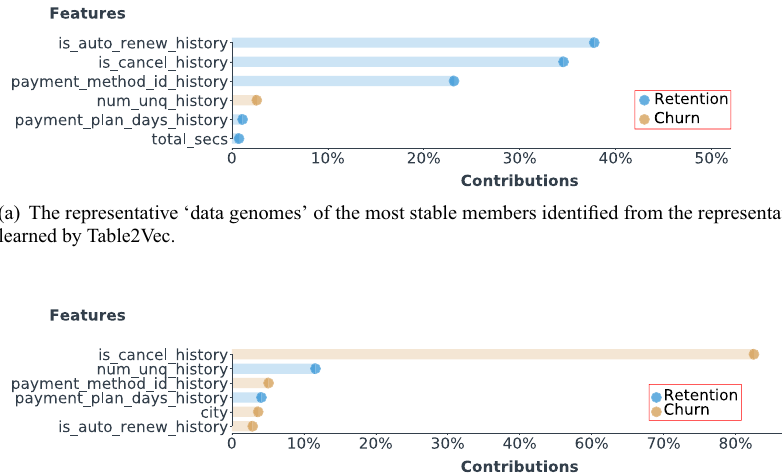
Figure 14. The representative ‘data genomes’ discriminating customer churn vs. retention in the Kaggle data set. The most representative genomic factors of a customer and their intrinsic contributions to customer churn or retention are discovered by the Table2Vec interpretation